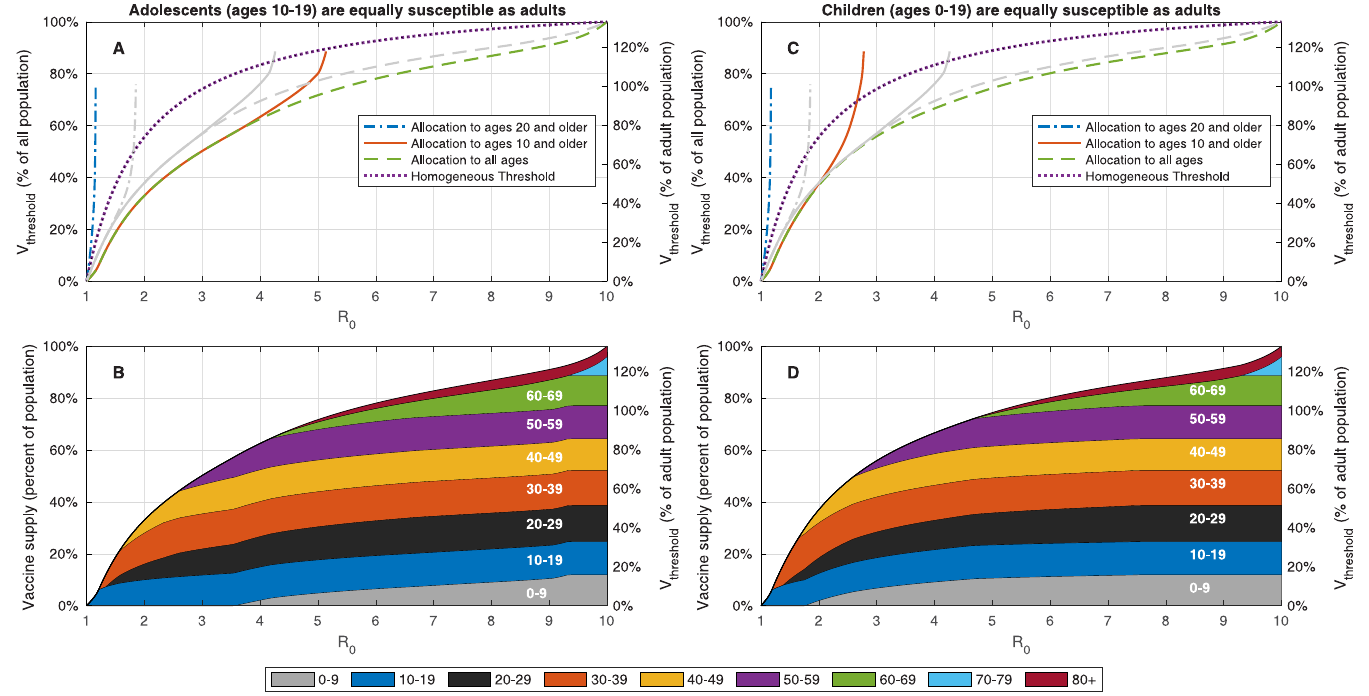
Fig 8. Effect of change in childrens’ susceptibility on vaccination coverage required for herd immunity. A,C: Vaccine coverage V threshold required to achieve herd immunity threshold as a function of the reproduction number R 0 for the USA demography and contact structure. The gray curves correspond to the case in which the relative susceptibility of age group 0–19 is half that of adults. B,D: Vaccine allocations at which herd immunity is achieved at minimal vaccine coverage and when there is no age restriction on vaccine allocation.